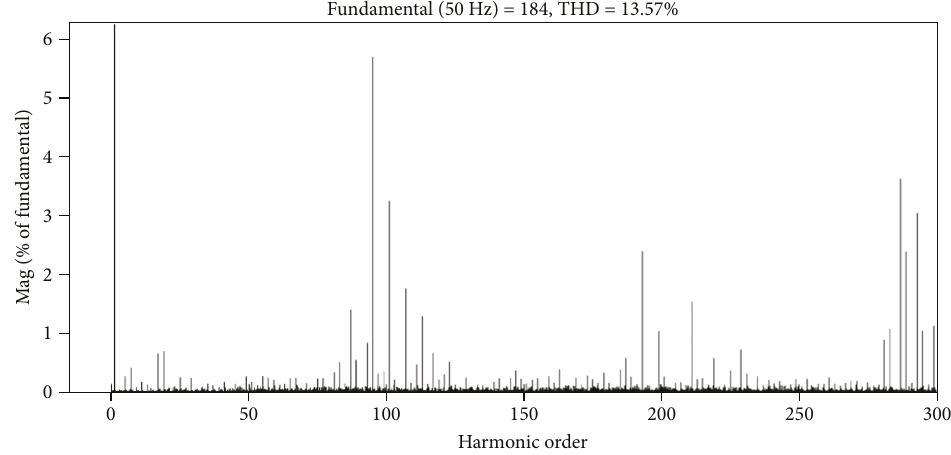
Figure 19: THD of the HMC output voltage.